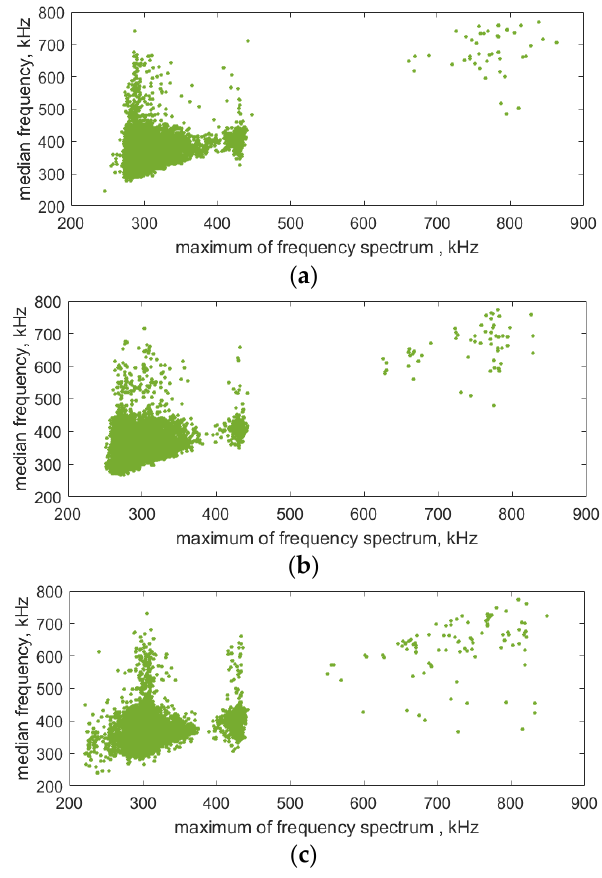
Figure 5. Dependence of the median frequency on the maximum of frequency spectrum of AE pulses registered during the quasi-static uniaxial tension of woven laminate samples (warp ( a ), weft ( b )) and unidirectional CFRP samples ( c ) (a single point corresponds to a single pulse).